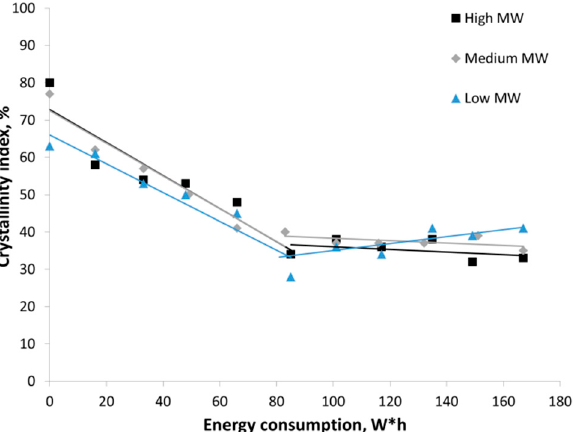
Figure 8. Changes in the crystallinity index of high, medium, and low MW chitosan as a function of power consumption during mechanical treatment.